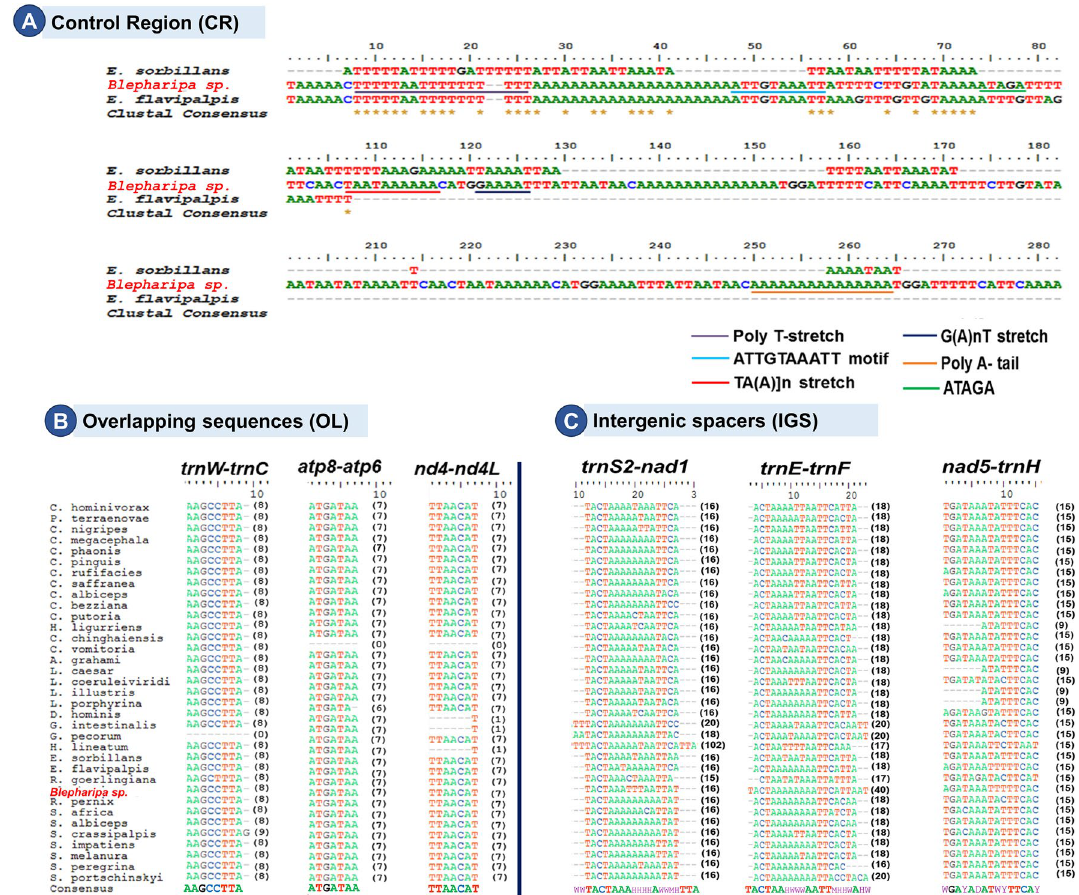
Figure 3. Conserved non-coding regions; ( A ) AT rich control region Alignment of Blepharipa sp. with other two Tachinidae species. ( B ) Three alignments of the common overlap region between trnW-trnC , atp8-atp6 and nad4-nad4l . ( C ) Three alignment of the consensus gap region between trnS2-nad1 (TAC TAA AHHHHAWWMH), trnE-trnF (ACTAAHWWW AAT TMHHWA), nad5-trnH (WGAYADATW YTT CAY) genes of all 36 Oestroidea mitogenome (where, W = A/T, H = A/T/C, Y = T/C, D = G/T/A, M =